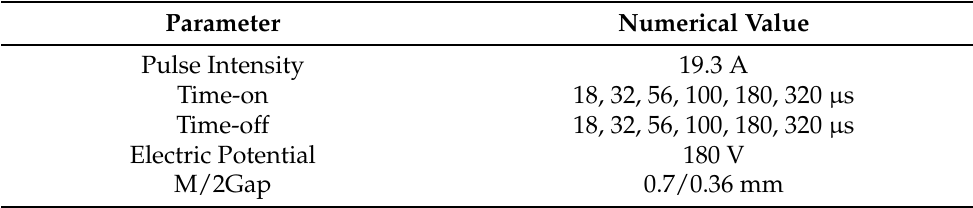
Table 2. Experimental parameters.